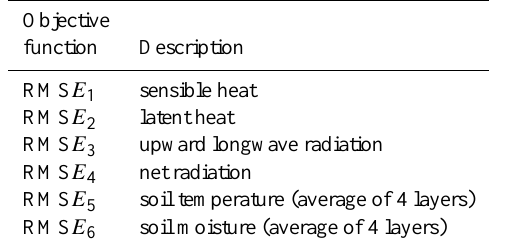
Table 3. The objective